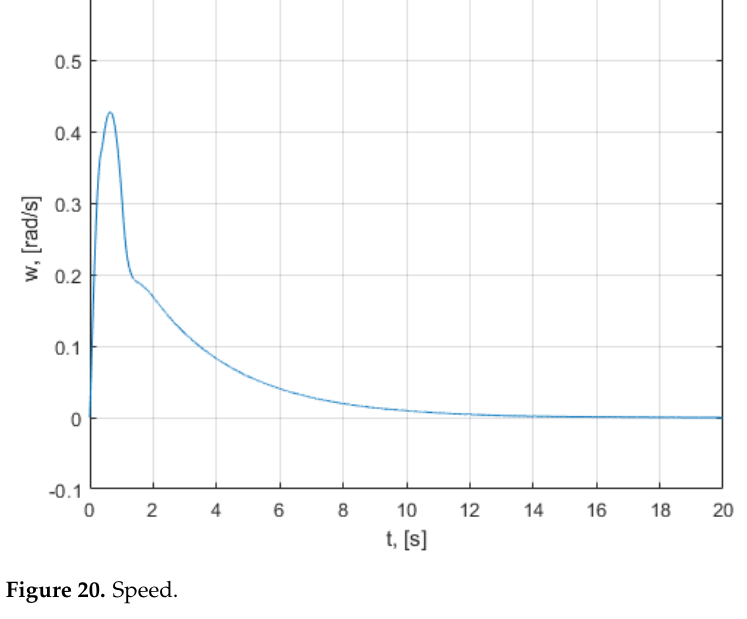
Figure 19. Torque.